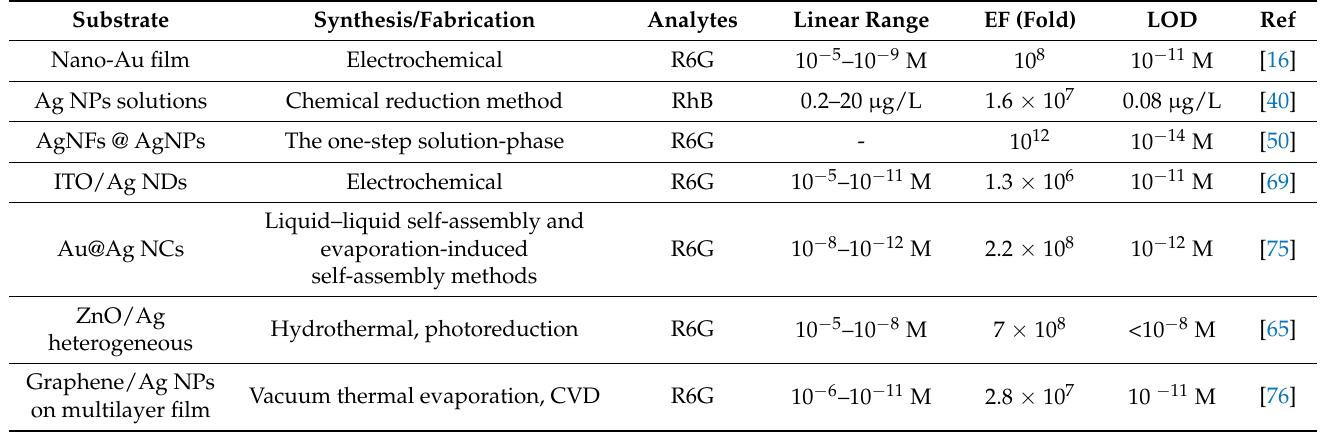
Table 1. A comparison of SERS substrates has been used to detect rhodamine